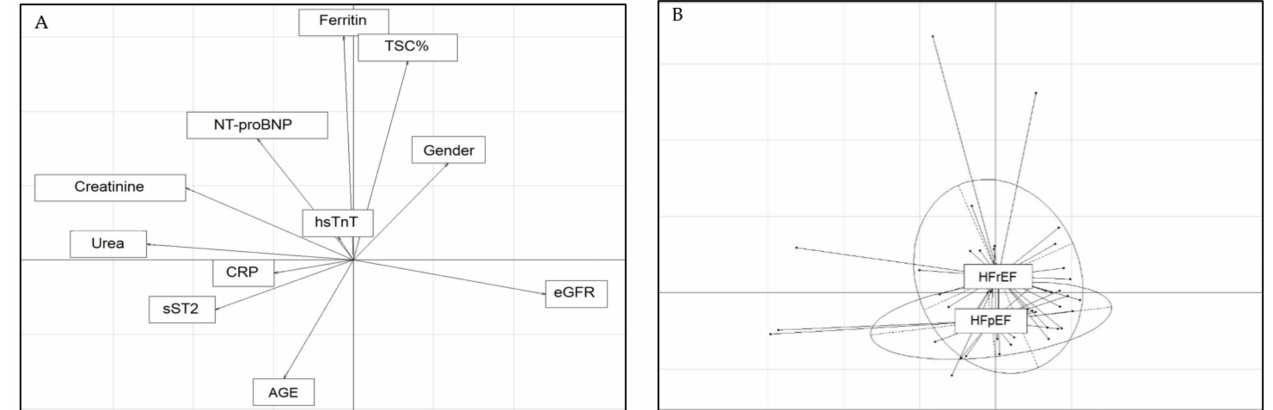
Figure 1. Arrow ( A ) and class ( B ) plots for clinical and biochemical metrics. ( A ) Arrow plot for clinical and biochemical metrics as a projection on two axes of the whole metrics used in the prediction model. ( B ) Class plot showed the same axis set-up but with the projection of the two respective HF groups of patients.